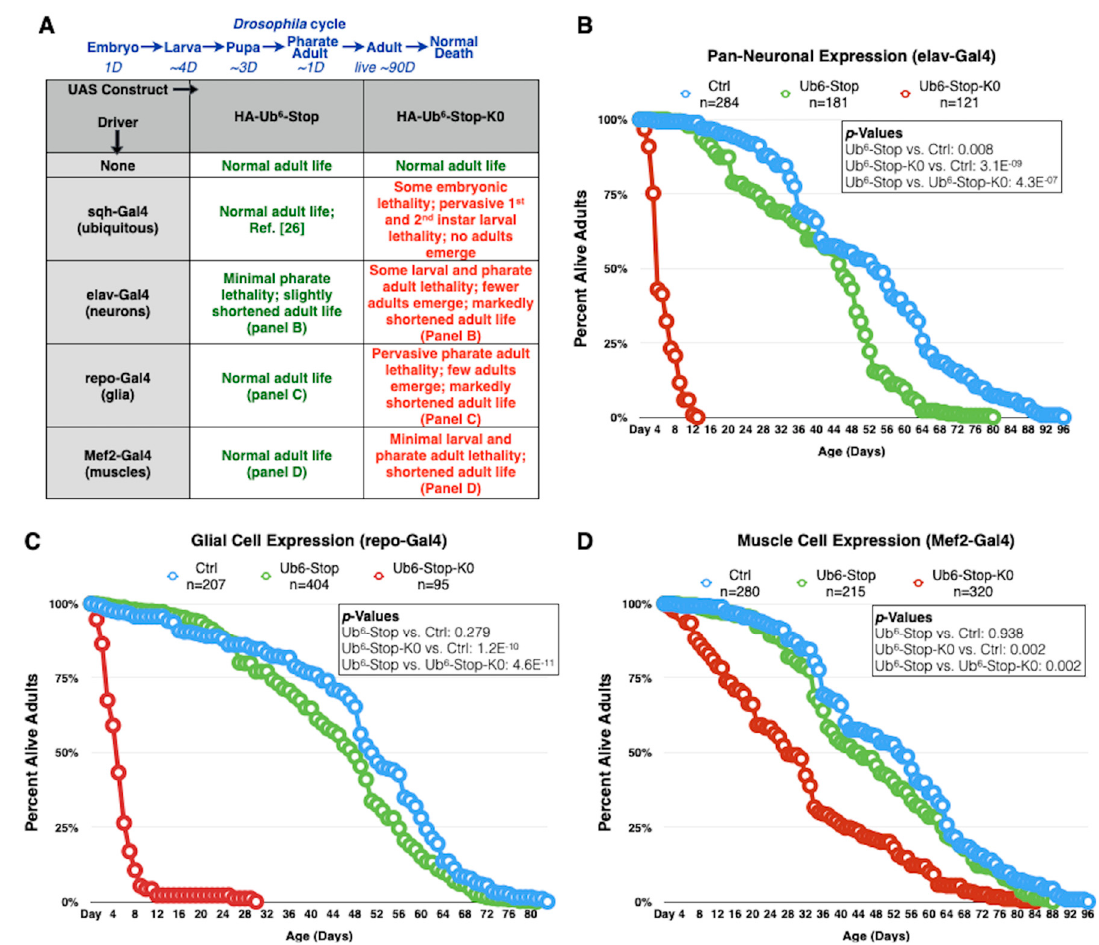
Figure 2. Lysine-less, non-cleavable ubiquitin chains are toxic in flies. ( A ) Summary of findings when the noted transgenes are expressed as indicated. “None” denotes flies that contained the indicated transgene without a Gal4 driver. Results are from crosses that were conducted simultaneously. A schematic of the fly life cycle, with the approximate number of days (“D”) spent in each stage, is provided. ( B – D ) Longevity assays of adult flies expressing Ub 6 chains under the noted Gal4 drivers. “Ctrls” do not contain Ub 6 transgenes, but have the Gal4 driver on the genetic background that we utilized to generate the ubiquitin chain-containing flies. ‘ p ’ values are from log-rank tests.